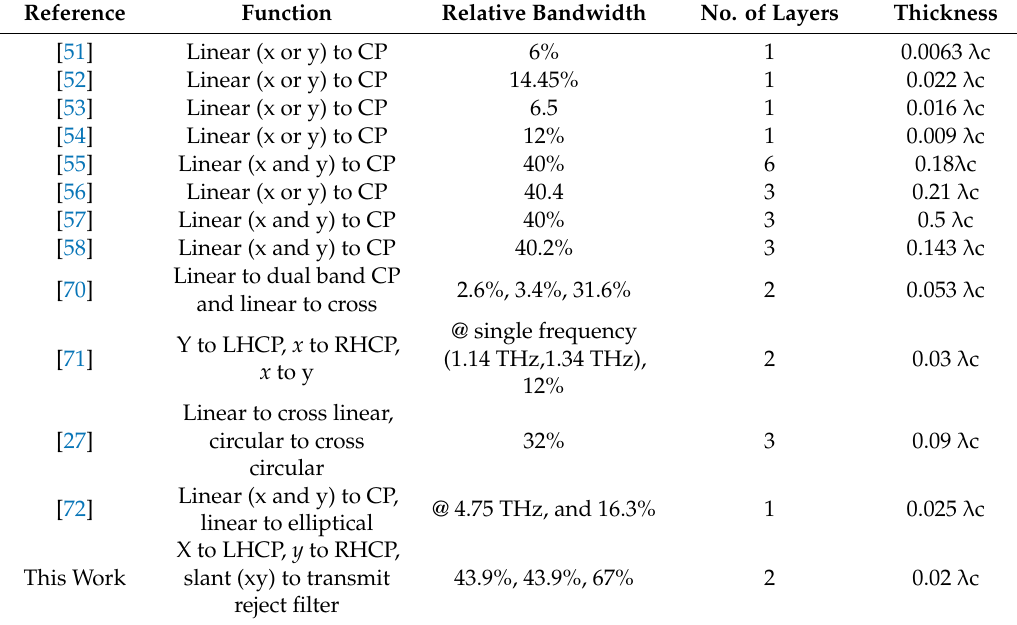
Table 1. Comparisons of the proposed polarization manipulator with other polarization converters / multifunctional